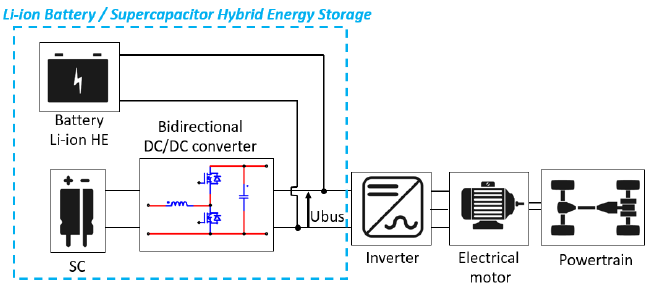
Figure 2. Schematic of the hybrid source studied [37].